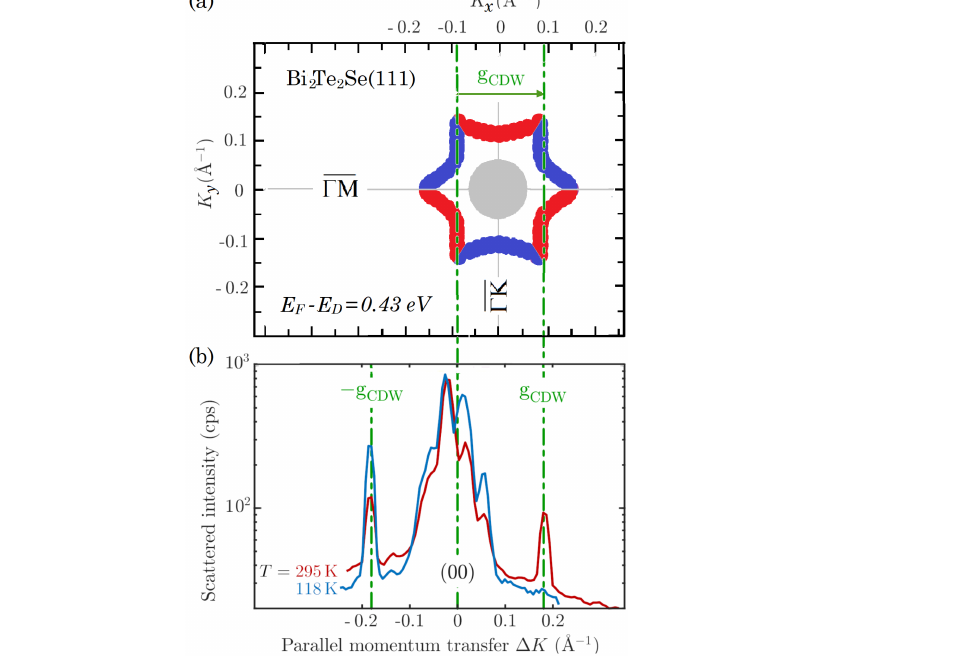
Figure 3. Illustration of the spin-allowed nesting condition in ( a ), giving rise to the sharp CDW satellite peaks at ± g CDW around the ( 00 ) -reflection in ( b ). HAS diffraction scans of Bi 2 Te 2 Se(111) along the Γ M direction at room (295 K) and low (118 K) temperature in ( b ), show two sharp peaks at wavevectors ± g CDW , indicative of a surface CDW. While, at room temperature, the two diffraction peaks have about the same intensity, at 118K the peak intensity at − g CDW is almost doubled at the expense of the peak at + g CDW , which is vanishing. ( a ) The contours of the Dirac surface states at the Fermi level, derived from Nurmamat et al. surface band structure calculations [25] for a Fermi level 0.43eV above the Dirac point (see Figure 1c), form a hexastar (red and blue branches for states with spin-up and spin-down normal to the surface, respectively), with a clear nesting wavevector g CDW connecting parallel contours of equal spin. No such nesting occurs in the Γ K